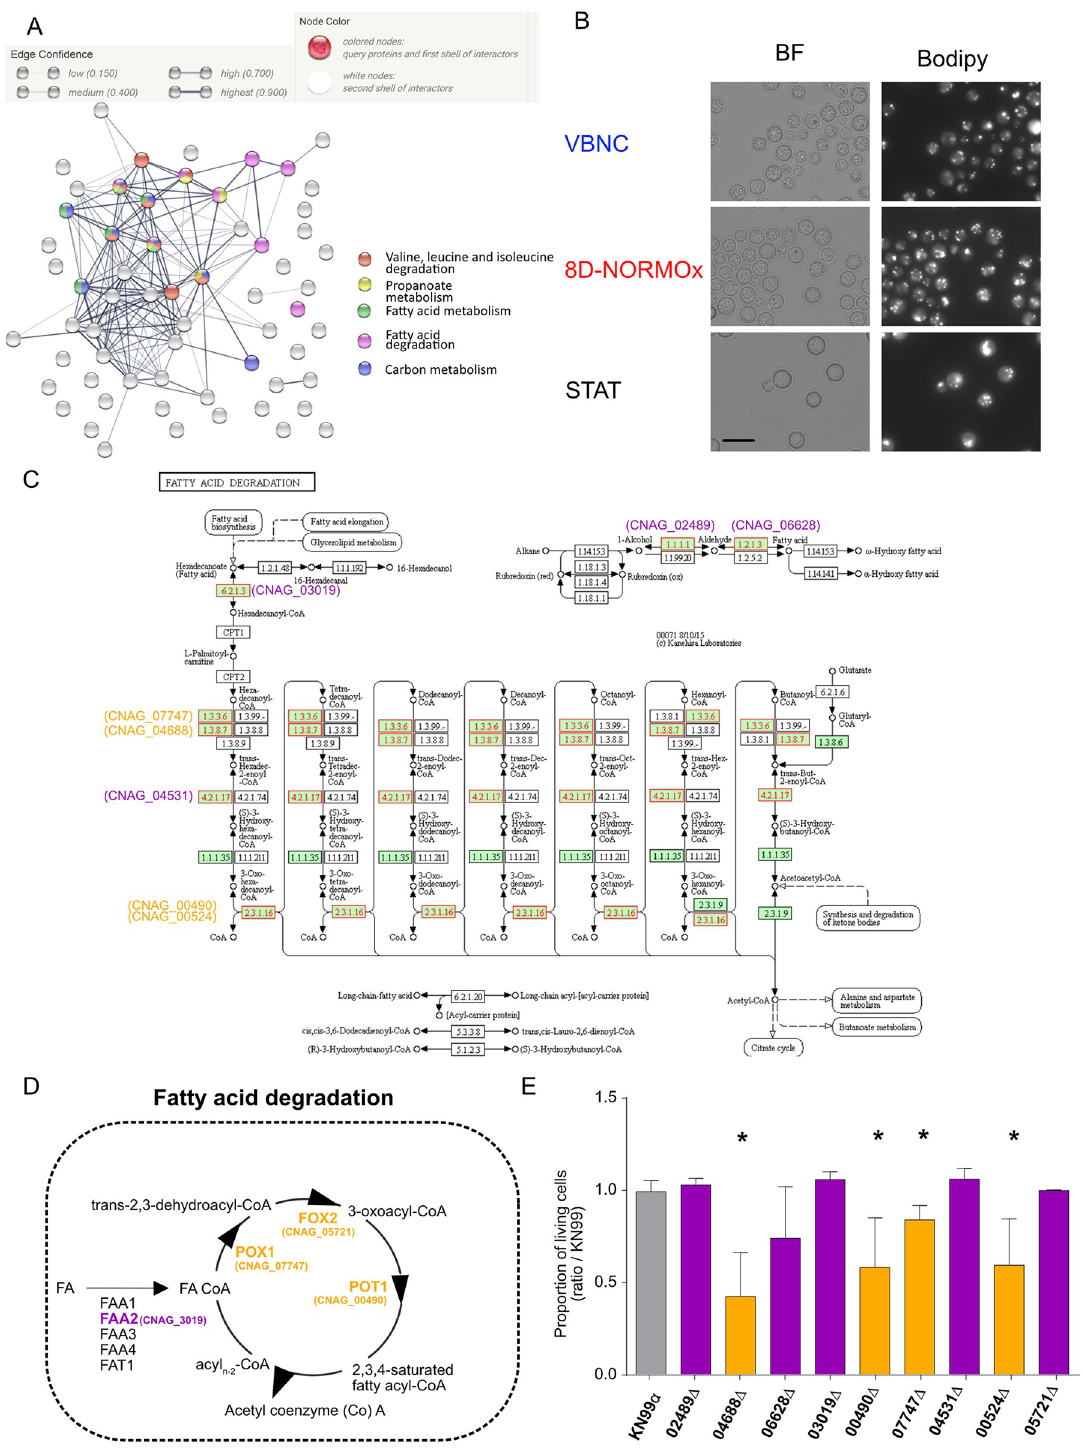
Fig 8. The fatty acid pathway participates in VBNC metabolism. A . The Search Tool for the Retrieval of Interacting Genes/Proteins (STRING) allowed the visualization of predicted protein-protein interaction for the 63 proteins hypoxia-regulated identified. It revealed an impact of hypoxia on diverse proteins as well as a prominent influence on fatty acids metabolism. Different clusters were identified from the network mapping: pathways linked to fatty acid metabolism (valine leucine and isoleucine degradation, propanoate metabolism, fatty acid degradation and metabolism) and to carbon metabolism. B . Lipid droplets stained with Bodipy 505/515 showed